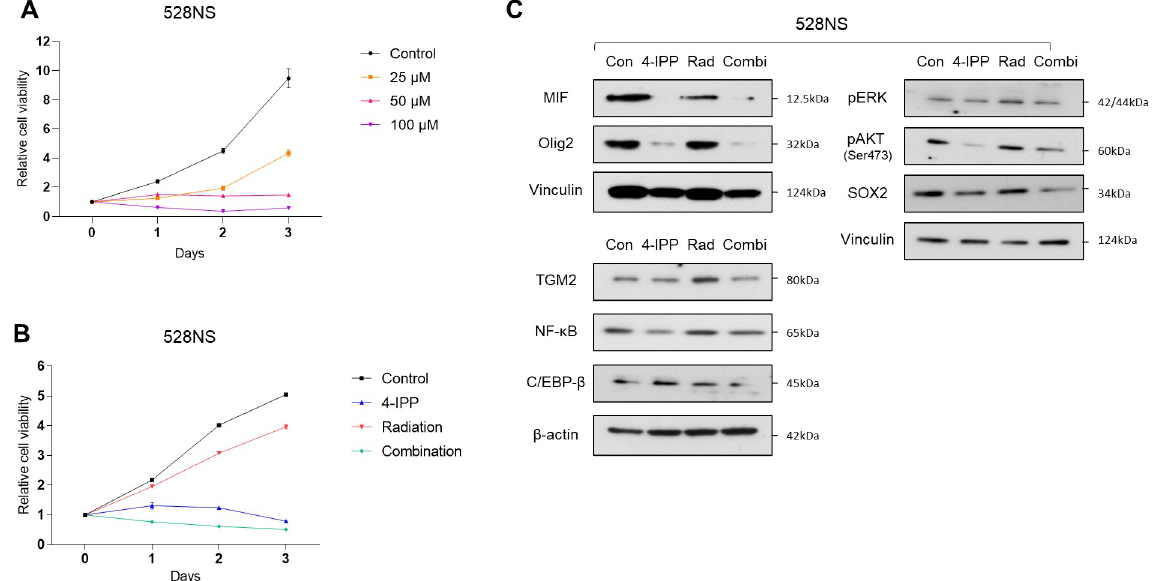
Fig 2. GSC after various treatments. (A) In vitro cytotoxicity test of 4-IPP in a time- and dose-dependent manner. (B) Survival curves of 528NS cells with various treatments are indicated. The effects of treatment were evaluated after treatment with the single and combinational application of 50 μ M 4-IPP and X-ray irradiation (6Gy). (C) Protein expression by Western blot in 528NS cells when treated by single or combinational administration of 4-IPP and radiation.